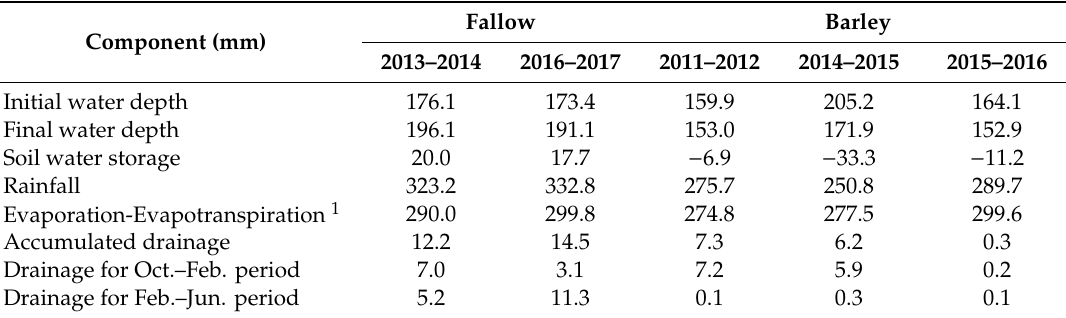
Table 6. Water balance components (mm) simulated with LEACHM model for five di ff erent periods (fallow and barley crop) using ECH2O data set for calibration. Simulation period: 1st October–30th June. Fallow Component (mm)